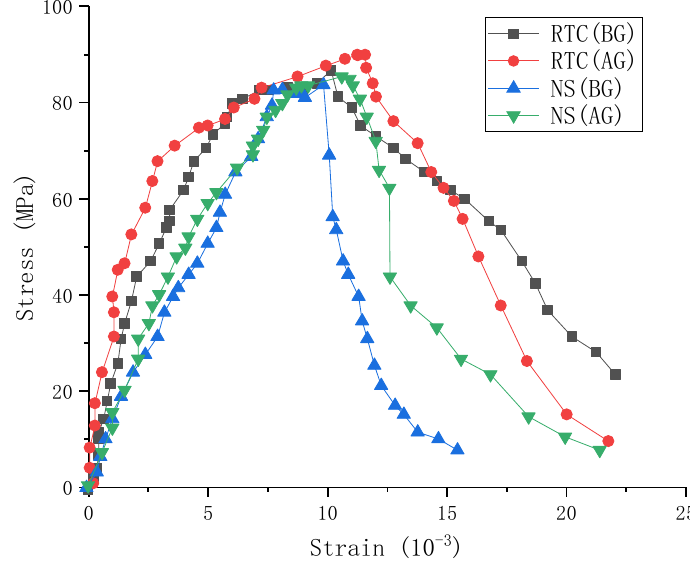
Figure 9. Comparison of uniaxial compression stress–strain curve experiment and numerical simulation (NS is the numerical simulation result).